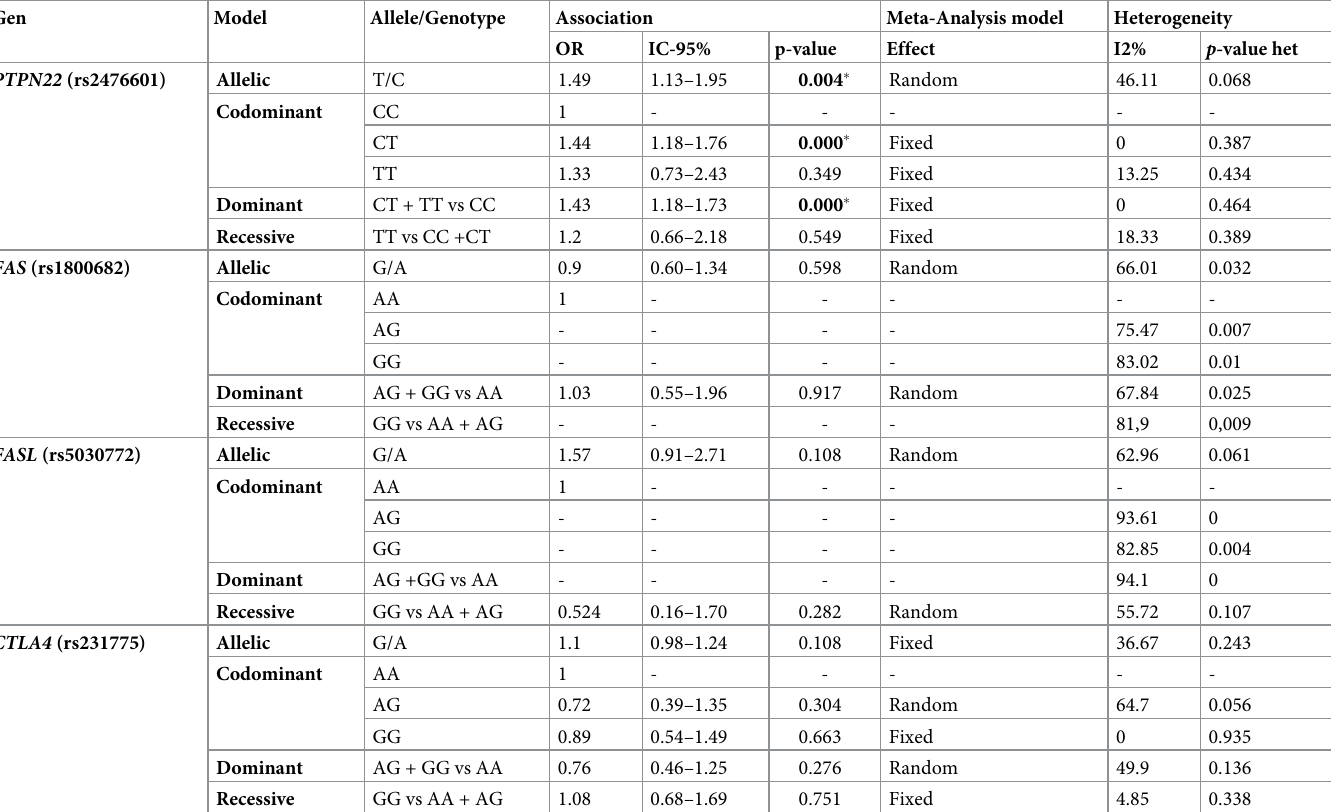
Table 4. Association between genes PTPN22 , FAS/FASL and CTLA4 with alopecia areata.